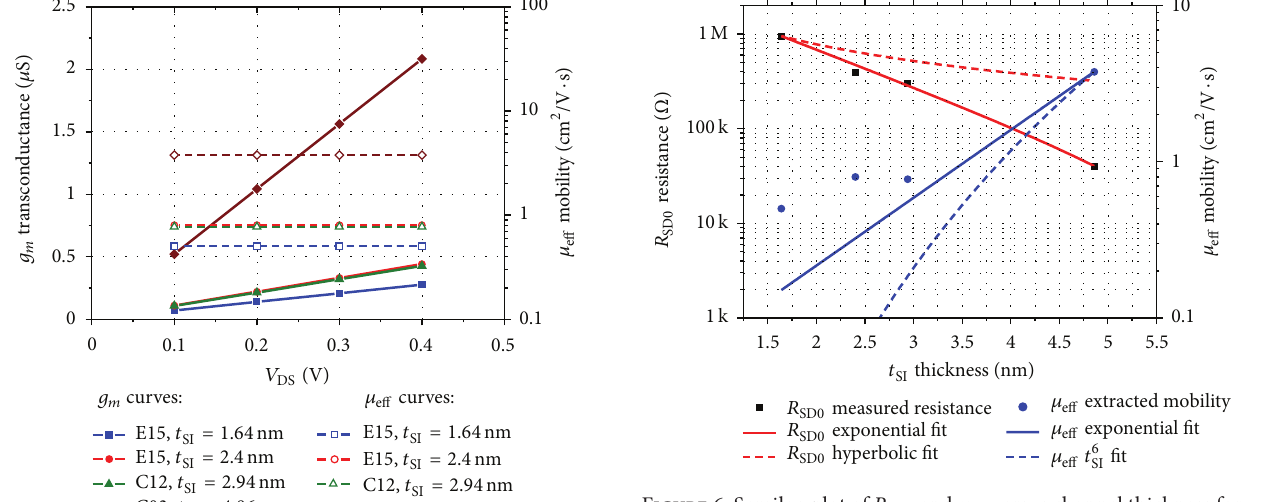
Figure 6: Semilog plot of 𝑅 and 𝜇 versus channel thickness for SD 0 eff four NSB devices (dices E15, C12, G15, and C03) having a channel ) of 1.6, 2.4, 2.9, and 4.9 nm, respectively. 𝑅 is thickness ( 𝑡 SI SD 0 constant value (0.1V) extracted from Figure 4 as the ratio of the 𝑉 DS . 𝜇 is extracted from (2). to the drain current measured at zero 𝑉 GS eff - DS